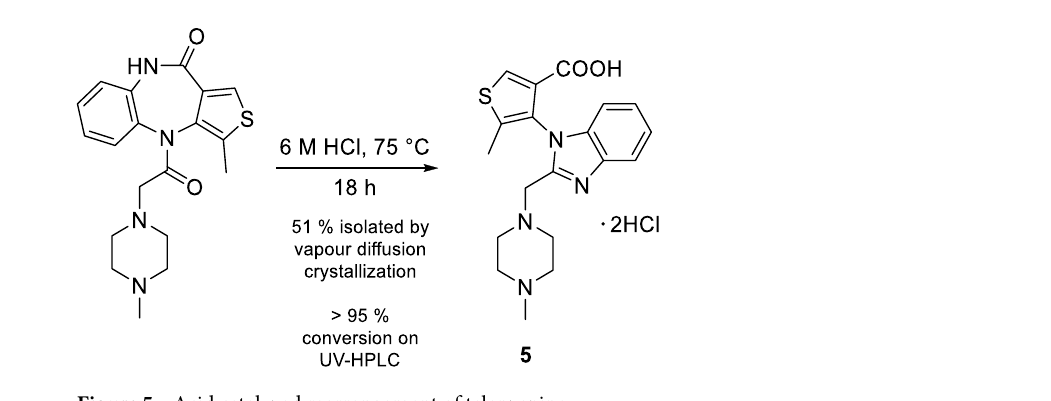
Figure 4. A: Kinetic data of the rearrangement of 2 in 6 M HCl at an initial concentration of 50 µg/mL as determined by HPLC. Error bars indicate the standard deviation of n = 3 measurements. Left: The kinetic profile of the rearrangement shows the conversion of 2 to 4 as function of time at different temperatures. The conversion is calculated normalized to the maximum area under the curve of 4 . The rearrangement follows a pseudo first order kinetic with half lifes of 25 ± 2 min (75 °C), 117 ± 16 min (55 °C) and 830 ± 30 min (37 °C). Right: Arrhenius plot illustrating a linear relationship between inverse temperature and logarithm of the rate constants. The activation energy of the reaction was delineated from the slope: 83.2 ± 1.9 kJ/mol. B: Reaction scheme showing the proposed reactive intermediate. Oxygens in the carboxylic acid group are indistinguisable, but for reasons of clarity only one of them is coloured like the hydrolyzing water.